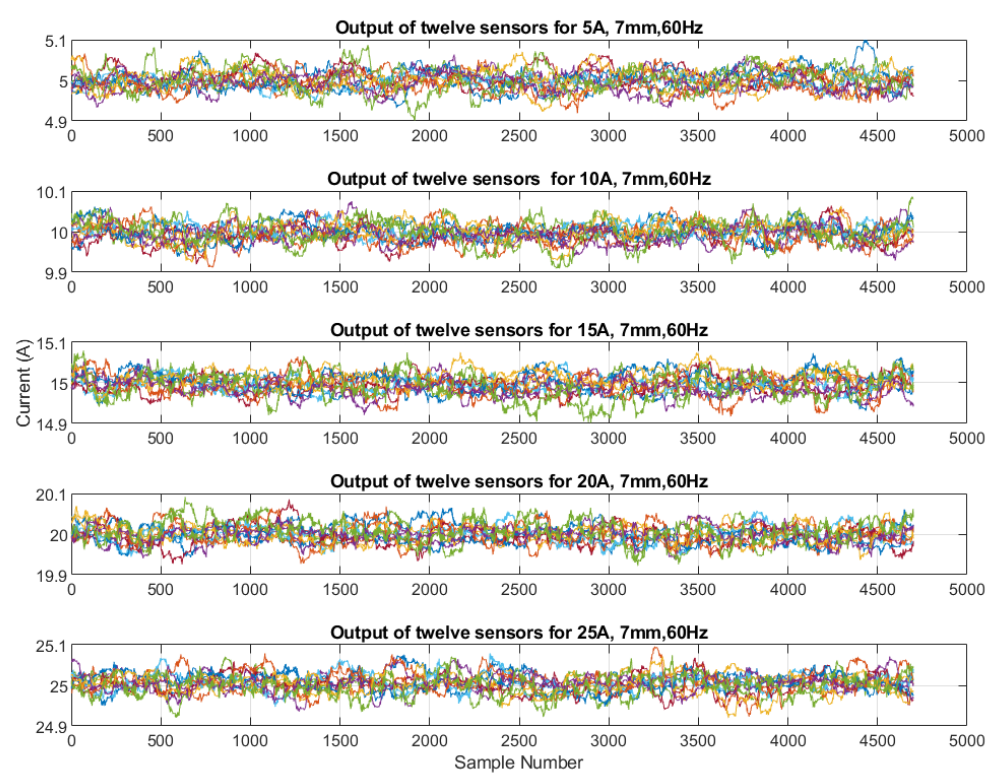
Figure 5. Output of all sensors for 5 A to 25 A for 7 mm, 60 Hz.